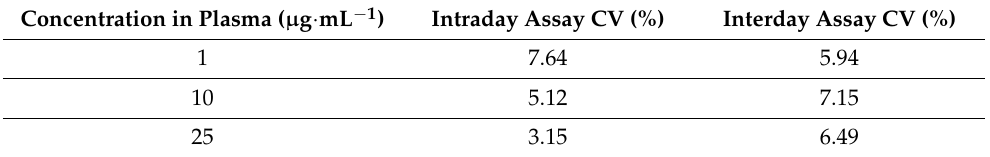
Table 3. Intraday and Interday assay coefficient of variance (% CV) in assay of meloxicam using